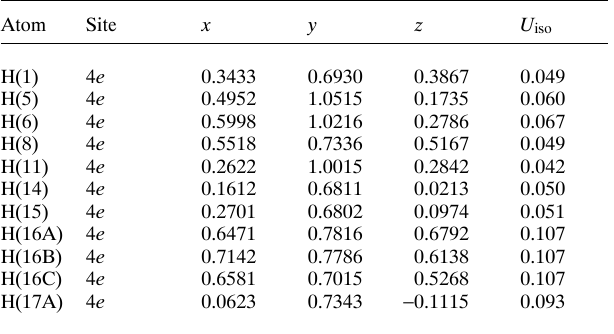
Table 2. A tomic coordin a tes a nd displ a cement p a r a meters (in Å 2 ) . Table 2. C ontinued